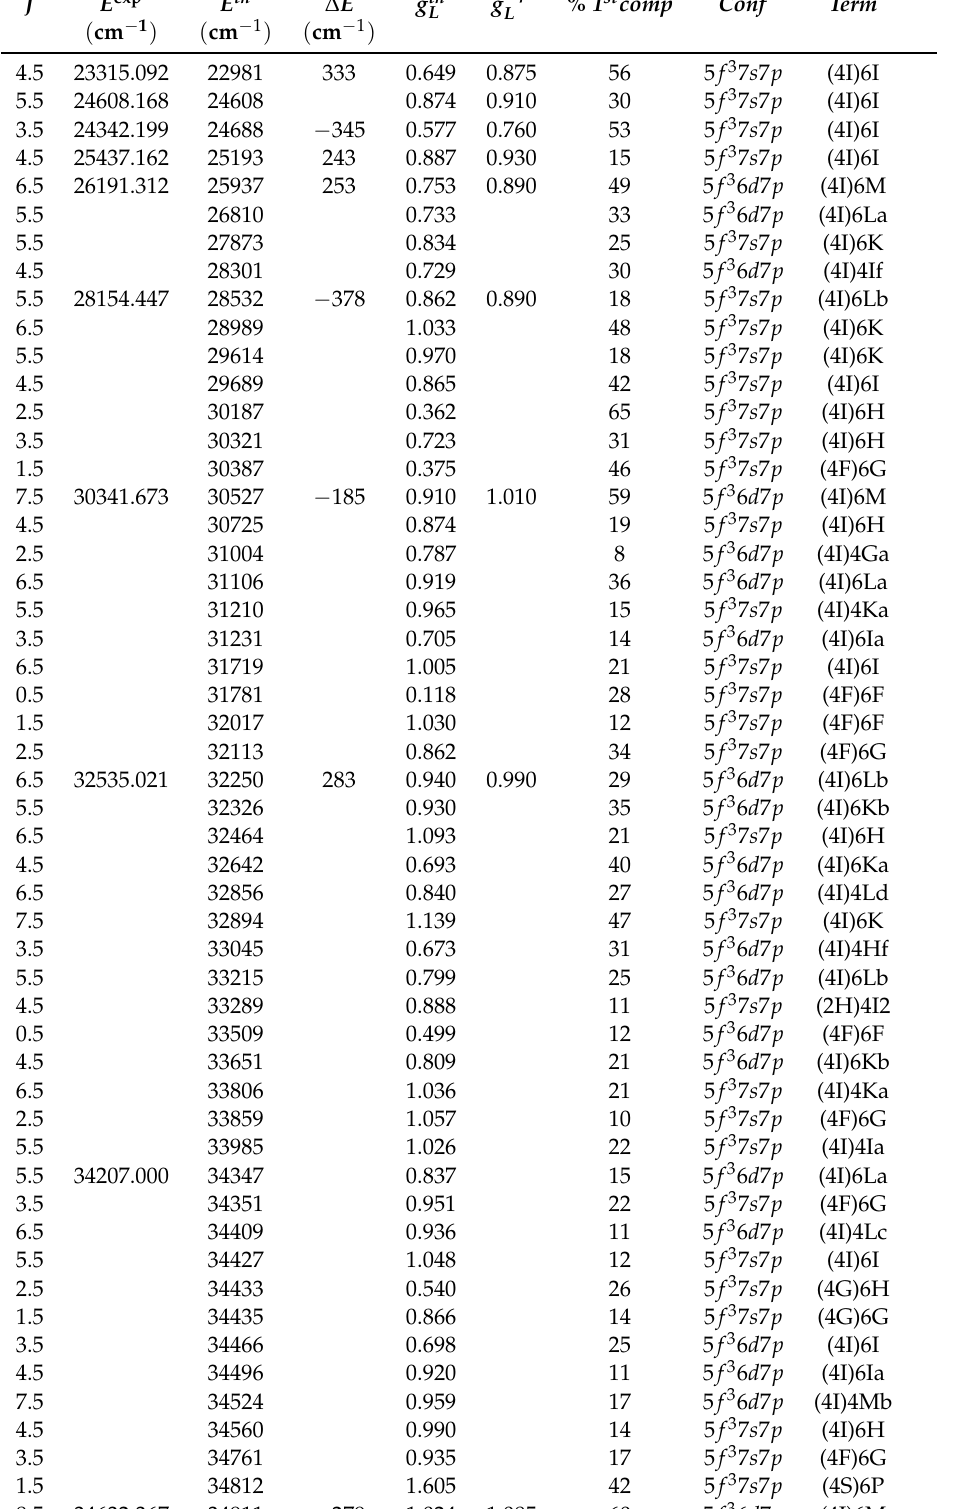
Table 8. Energy levels for even parity configurations 5 f 3 7 s 7 p and 5 f 3 6 d 7 p of U II. ∆ E = E exp − E th . The percentage, the configuration and the LS name of the leading component in the corresponding configuration are given in the last three